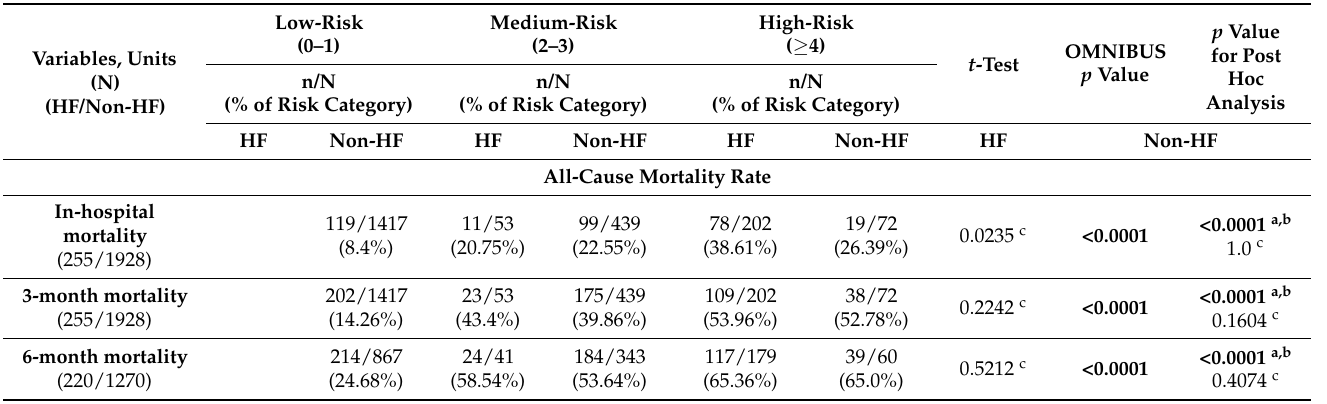
Table 4. Total and in-hospital all-cause mortality in the C 2 HEST risk strata in diabetes and non- diabetes